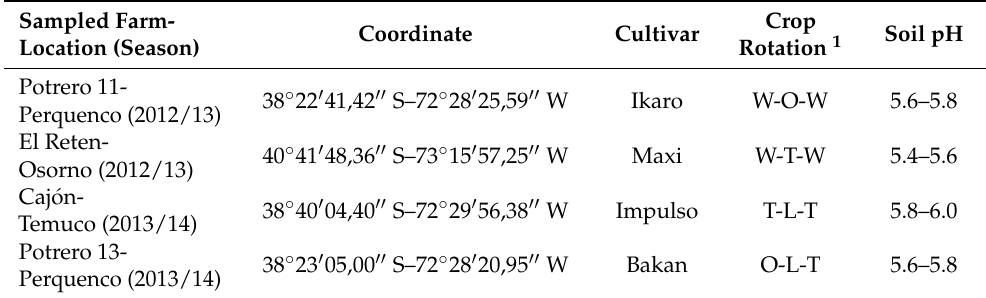
Table 1. Description of the crop location, season, cultivars, crop rotation, and pH range of the soil of the intensively surveyed fields evaluated in southern Chile for this